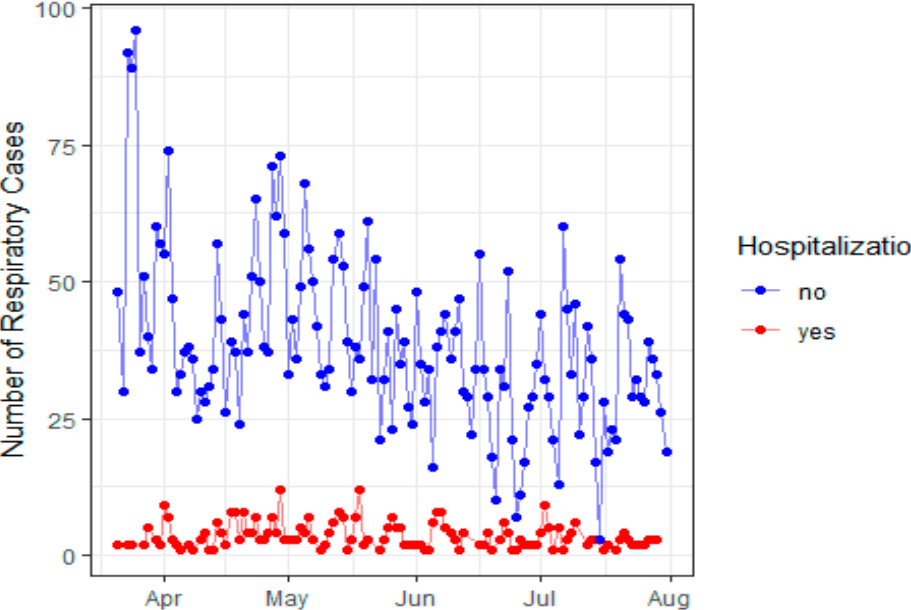
Figure 1. The total number of patients with respiratory signs and symptoms and the need for hospitalization and non-hospitalization, from March to August 2020, at São Paulo Hospital, São Paulo, Brazil.